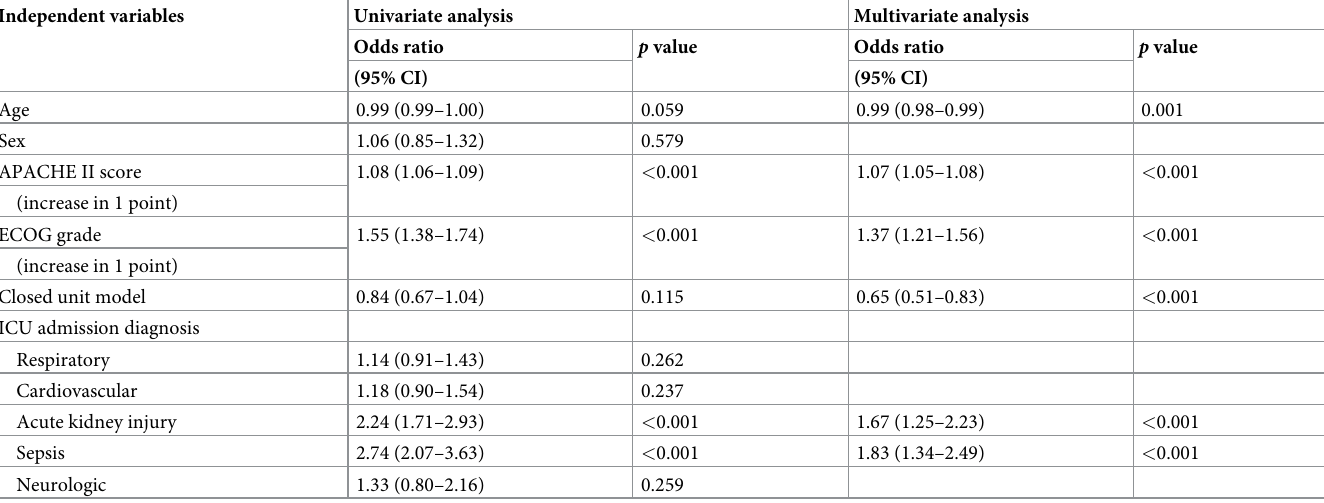
Table 3. Independent predictors of in-ICU mortality by multiple logistic regression analysis.